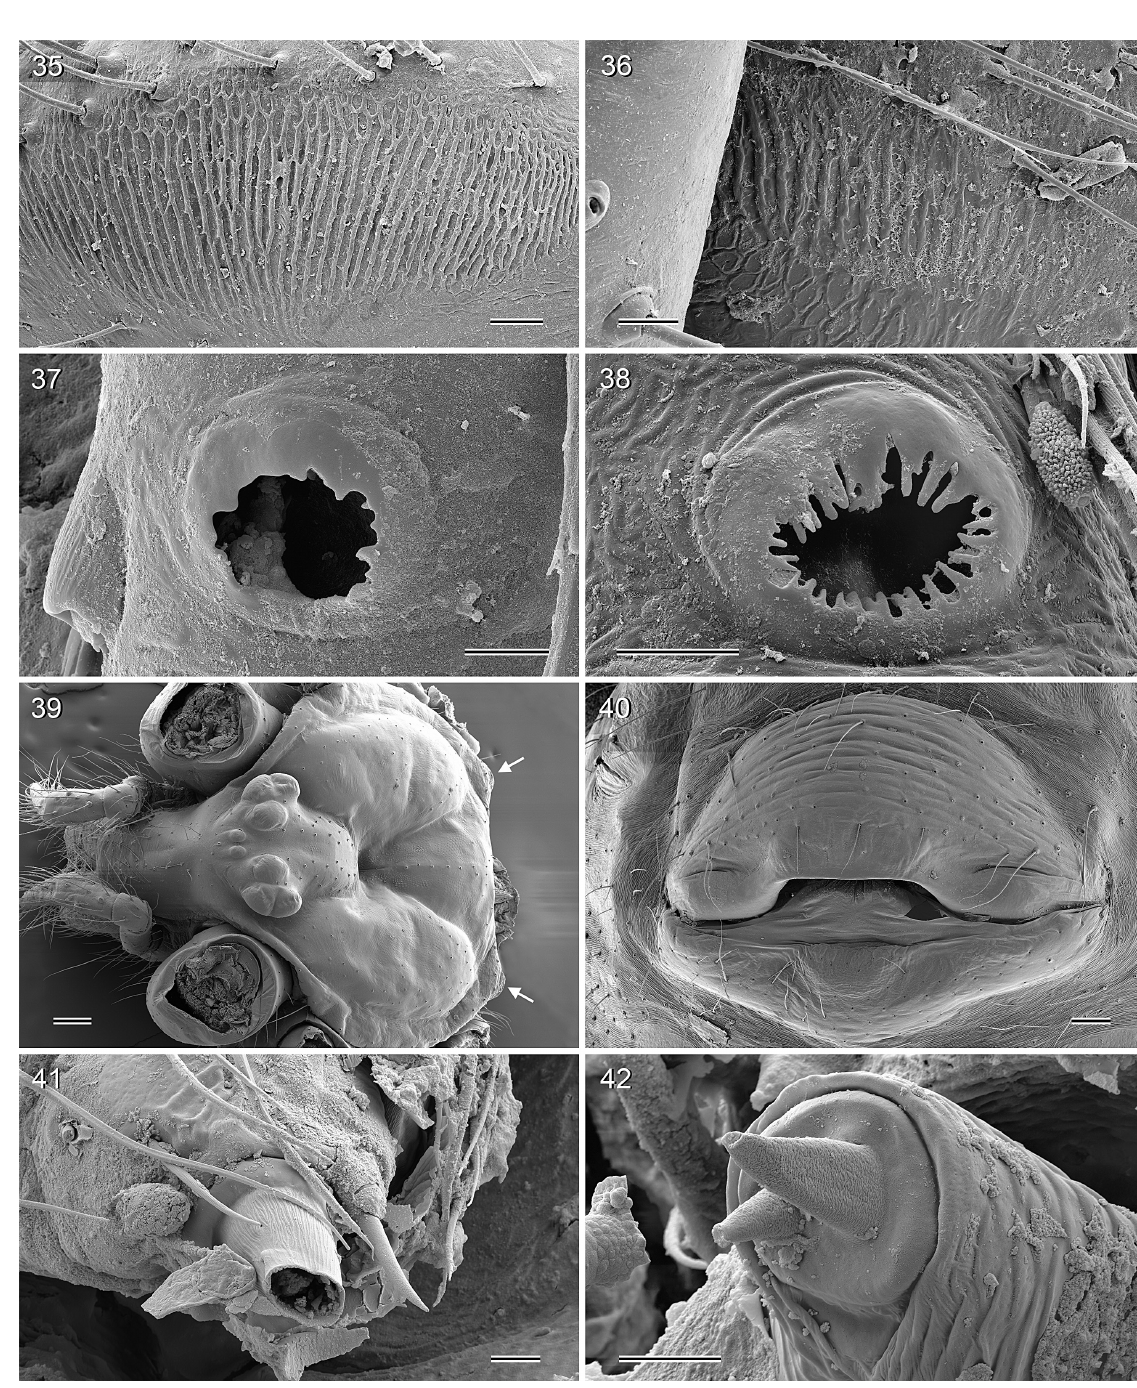
Figs 35–42. Stygopholcus absoloni (Kulczyński, 1914); male and female from Počitelj/Čapljina, Bosnia and Herzegovina (MHNG). 35–36 . Stridulatory files on male and female chelicerae. 37 . Female palpal tarsal organ. 38 . Tarsal organ on female tarsus 2. 39 . Female prosoma, oblique dorsal view; arrows point at posterior humps acting against modified areas on abdomen. 40 . Epigynum, ventral view. 41 . Female ALS. 42 . Female PMS. Scale bars: 35 = 30 µm; 36 = 20 µm; 37–38 = 10 µm, 39 = 200 µm; 40 = 100 µm; 41–42 = 10